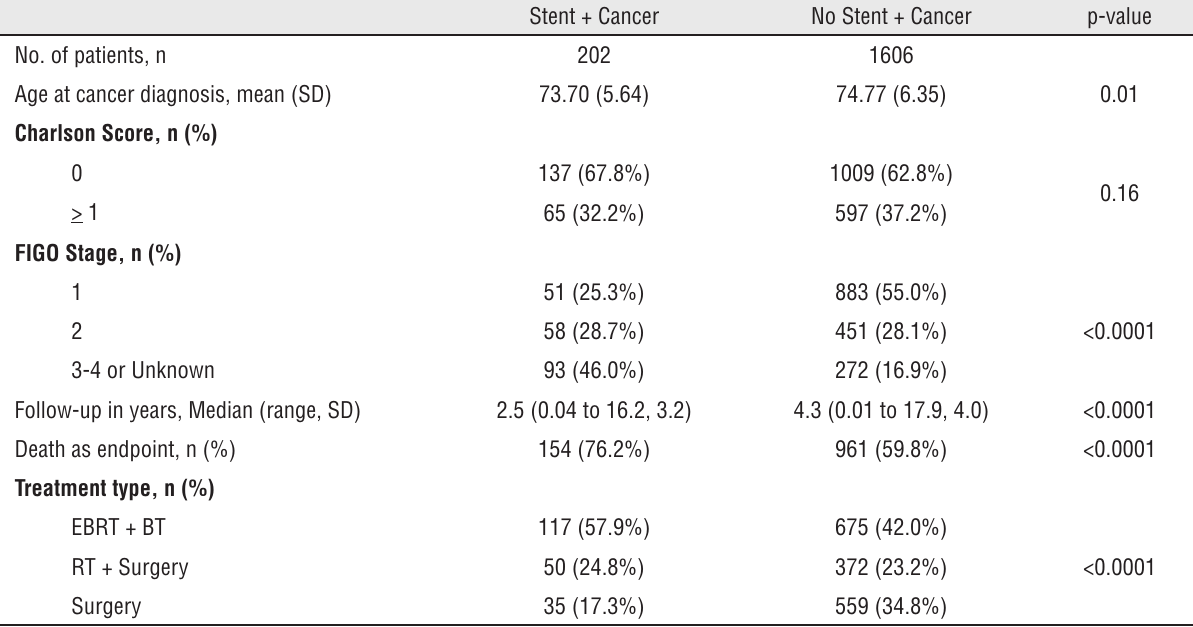
Table 1 - Demographic and clinical characteristics of women with cervical cancer by ureteral stent. Stent +